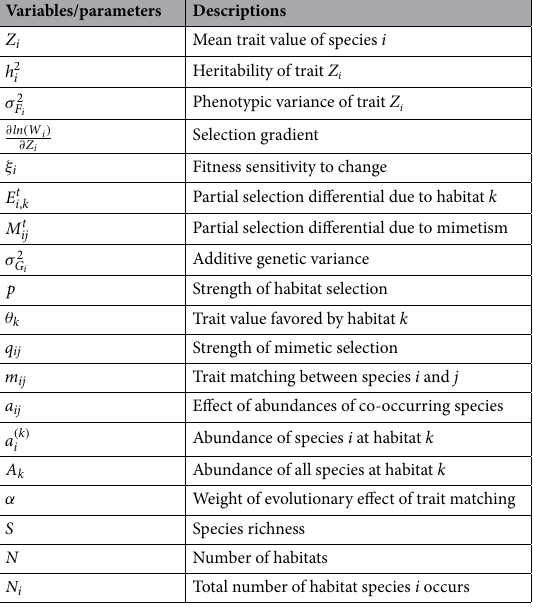
Table 1. Model variables and parameters and their